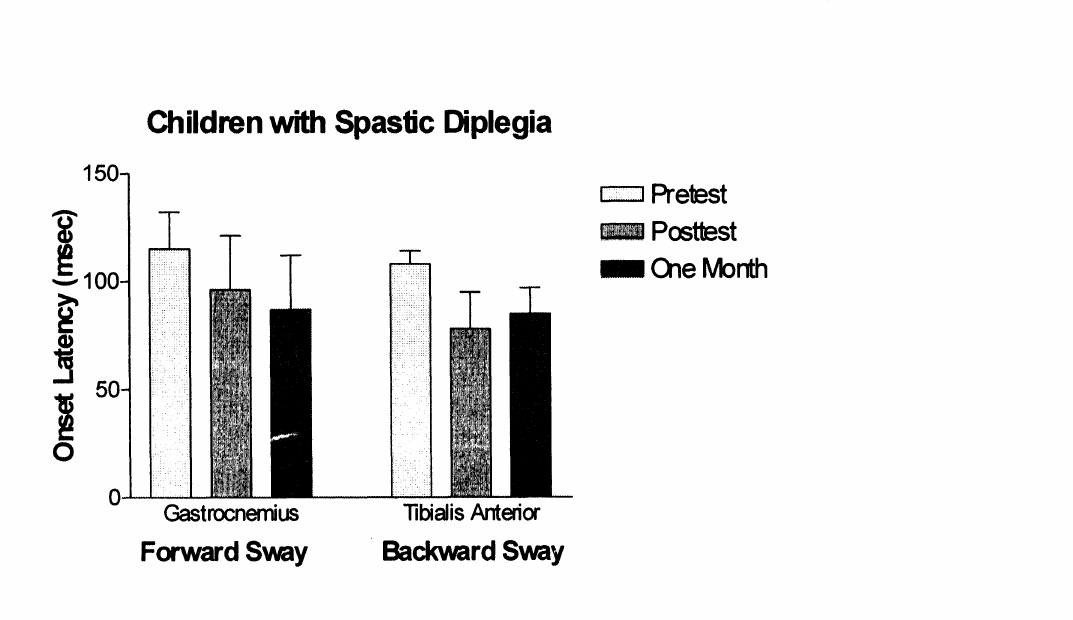
Fig. 4" Graph showing time of onset of contraction for the distal agonist muscles (gastrocnemius for forward sway and tibialis anterior for backward sway) for the children with spastic diplegia for pretest, posttest, and one month follow-up